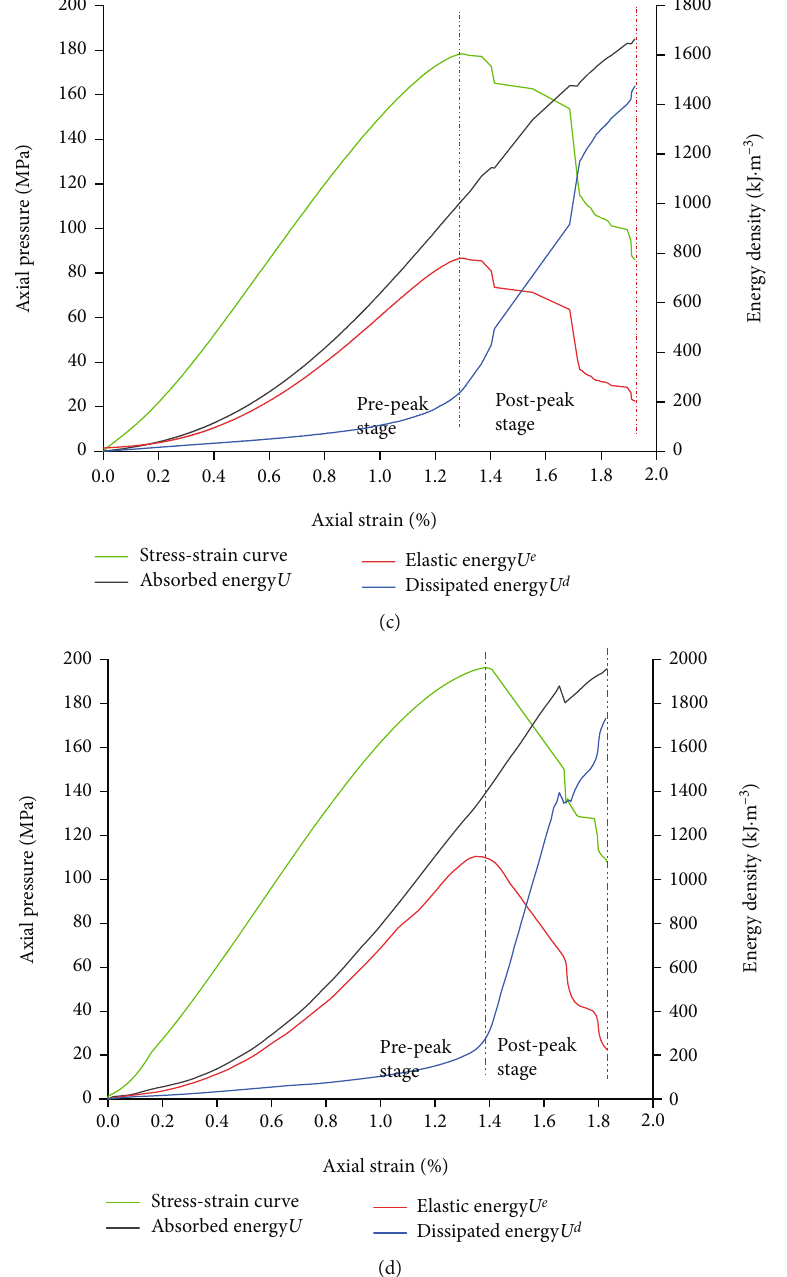
Figure 3: Energy evolution curve of sandstone under di ff erent con fi ning pressure. (a) Con fi ning pressure 5 MPa. (b) Con fi ning pressure 10MPa. (c) Con fi ning pressure 15MPa. (d) Con fi ning pressure 20